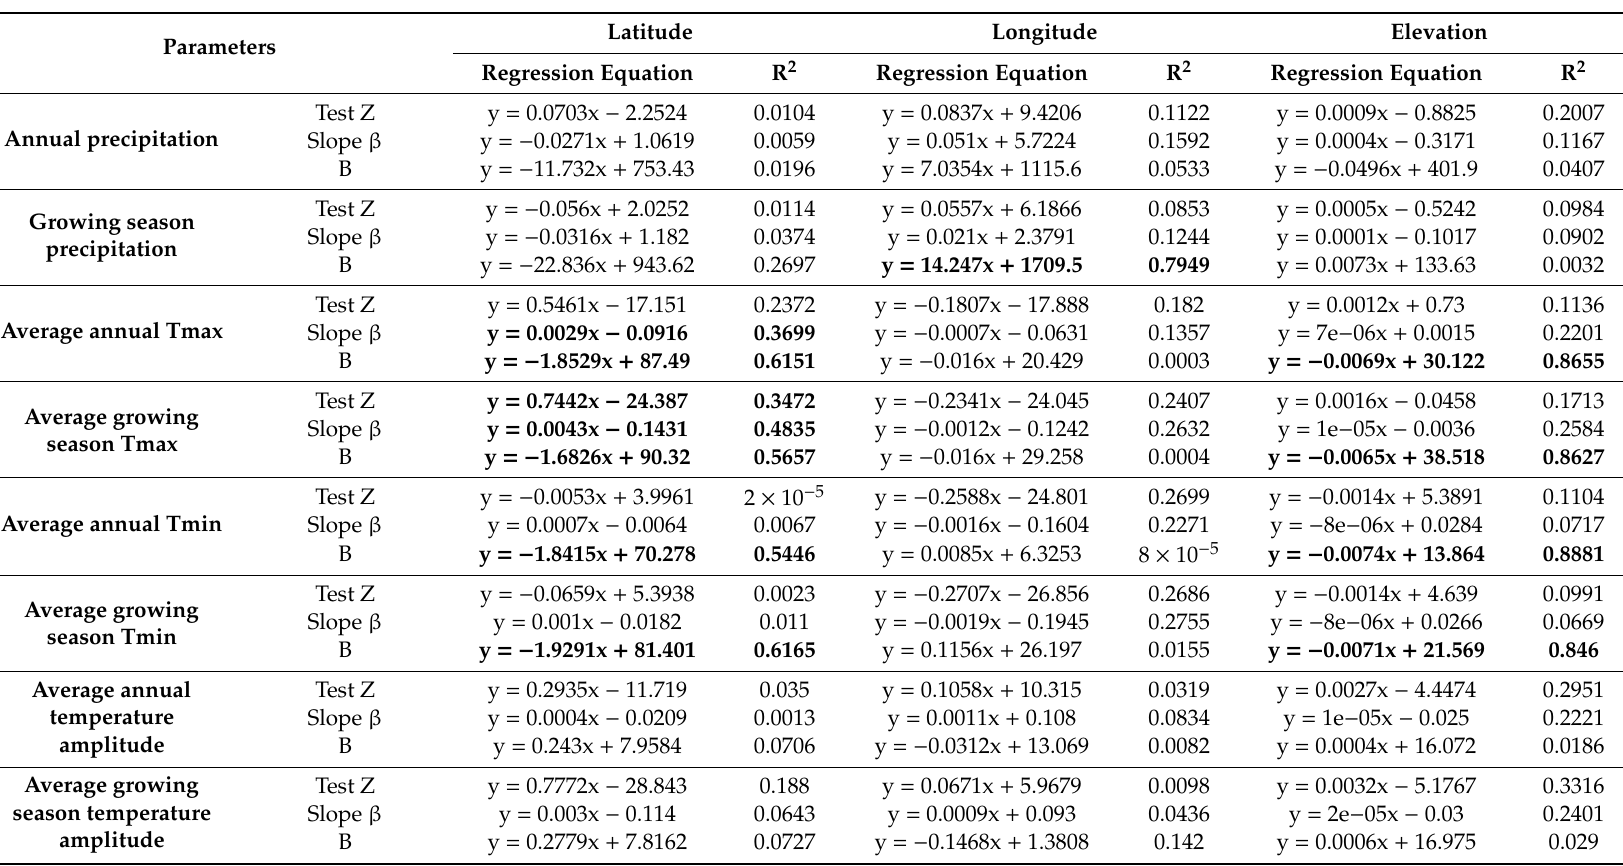
Table 6. Summary of the linear relationship between average annual and growing season precipitation and temperatures and temperature amplitude. Parameters